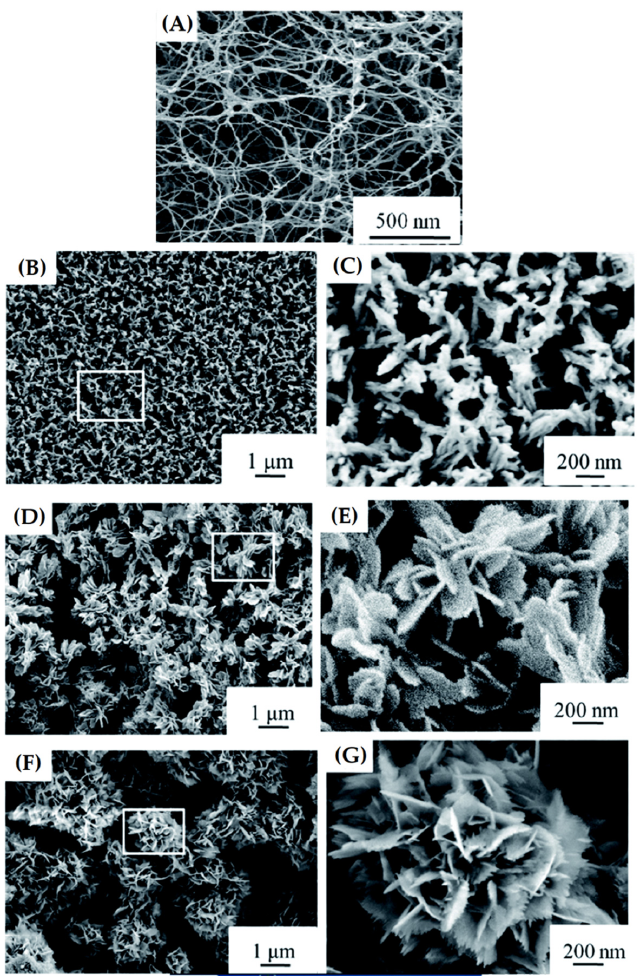
Figure 8. SEM images and the corresponding high magnification images of NBG scaffolds ( A ), after immersion in SBF for ( B , C ) one, ( D , E ) three, and ( F , G ) seven days (insets show local enlarged areas). Reprinted from [156], copyright (2018), with permission from RSC Advances.